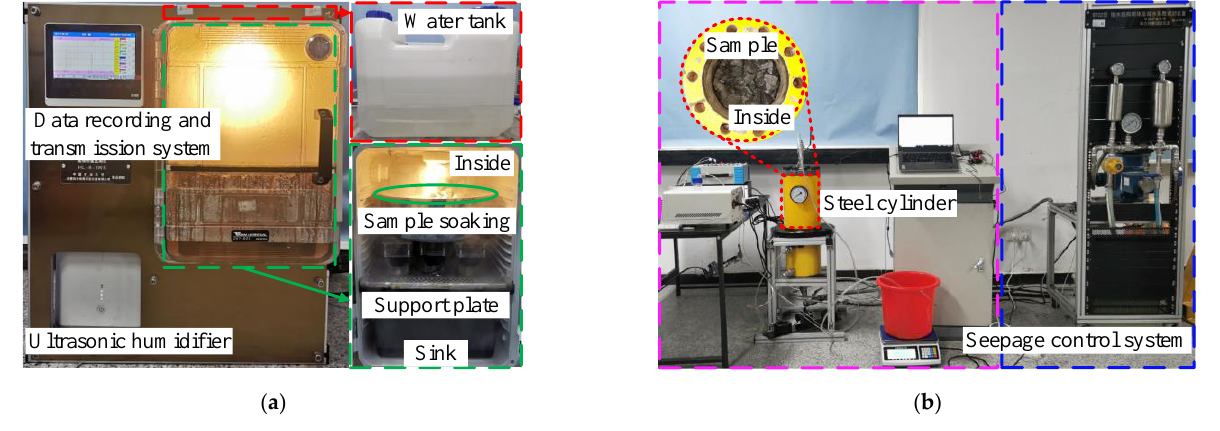
Figure 3. Gangue compression test equipment. ( a ) ANDWID. ( b ) BR-MSTS.